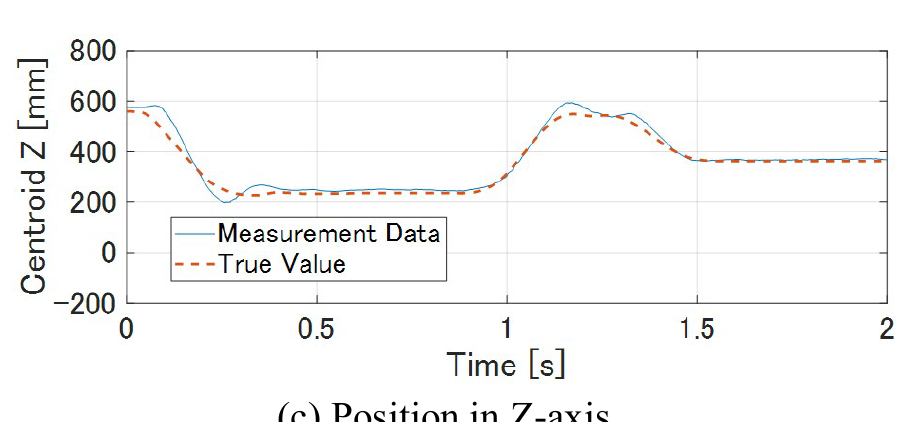
Figure 15. Centroid of ken